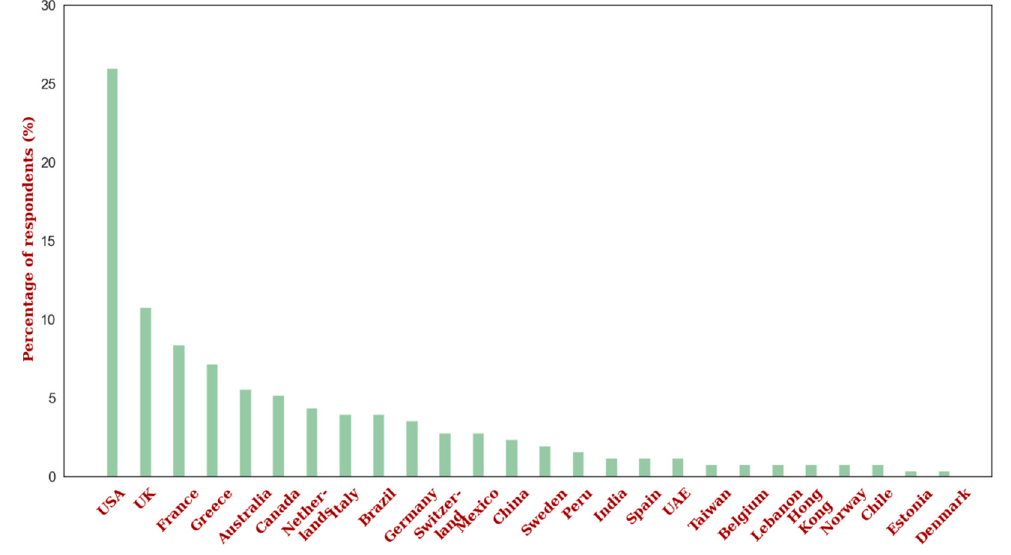
Figure 2. Countries of residence of the respondents to the survey .